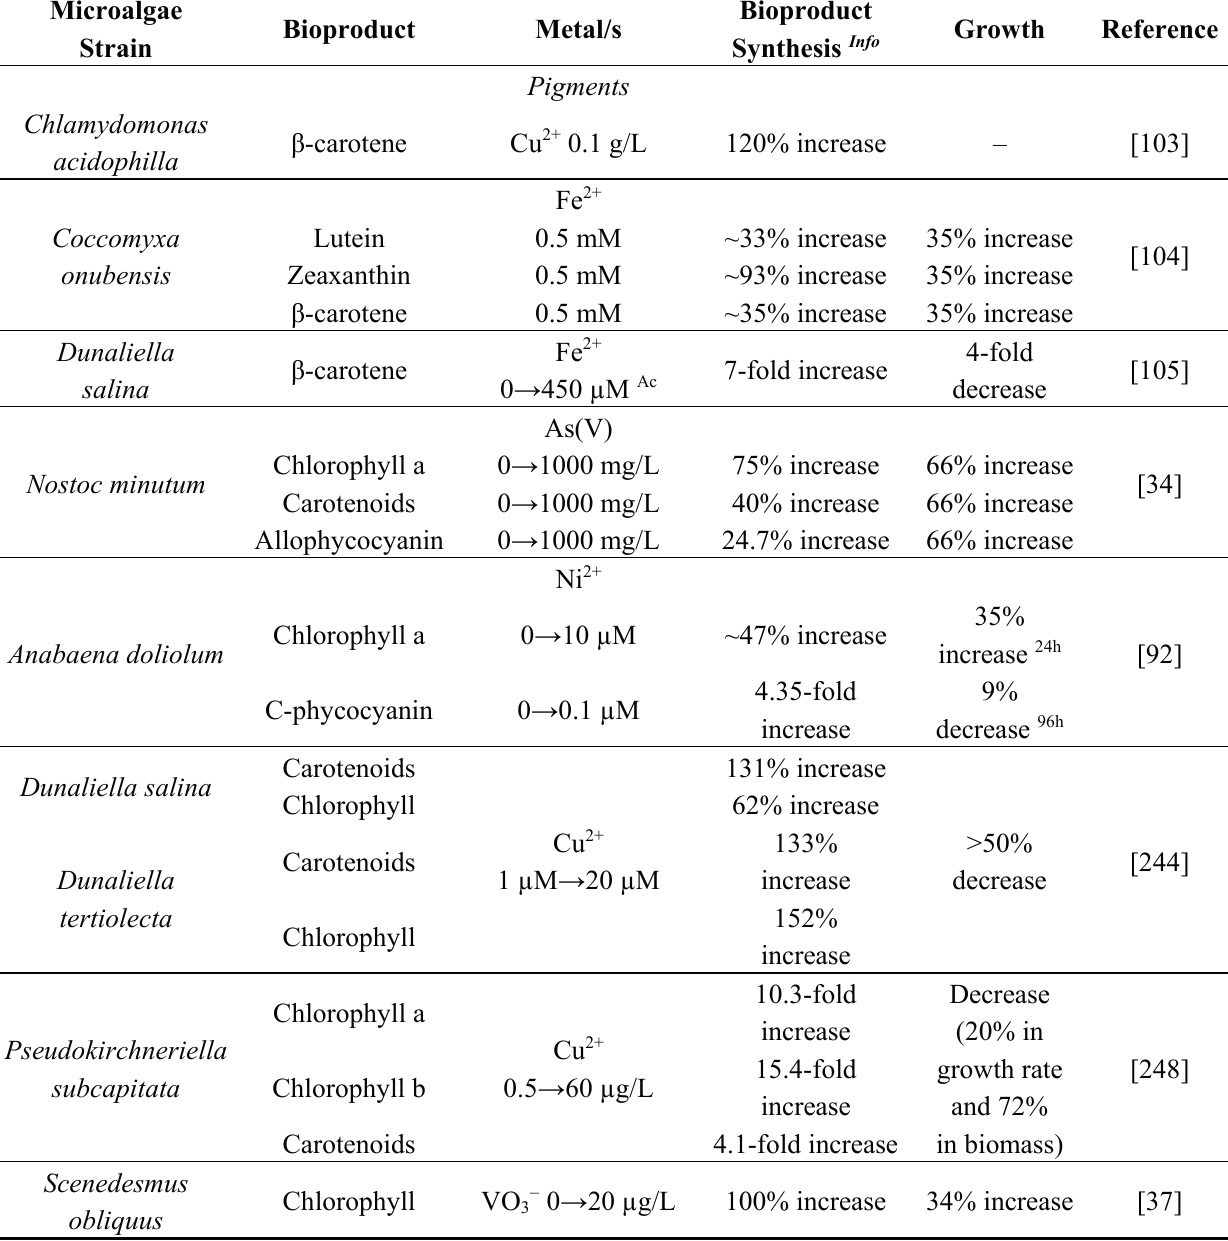
Table 6. Some examples of metal effects on microalgae growth and bioproduct synthesis.